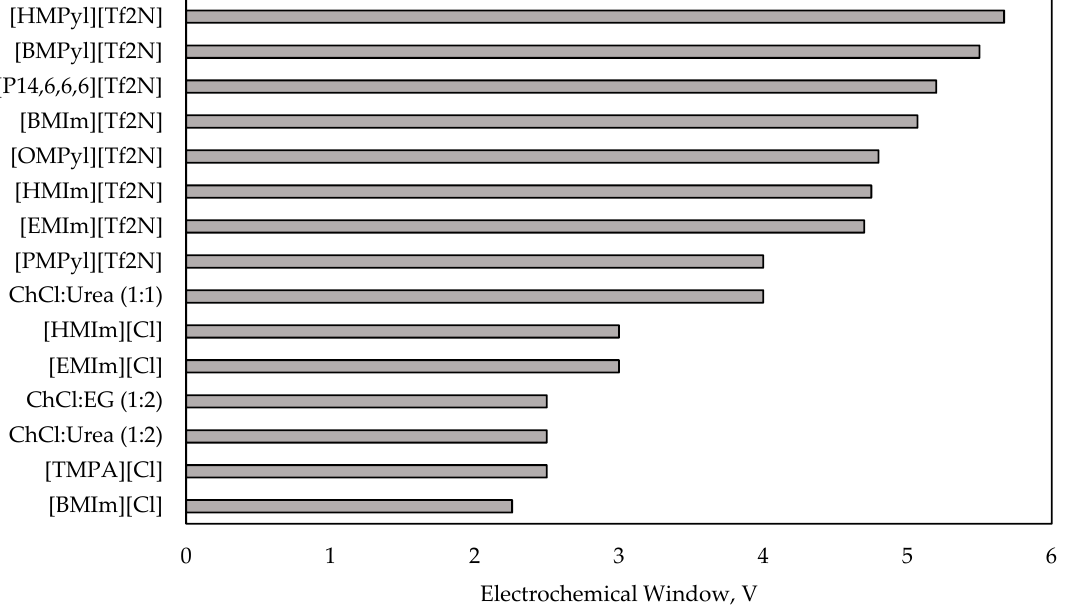
Figure 6. Plot showing the electrochemical windows of various ILs that are employed for the deposition of Al.